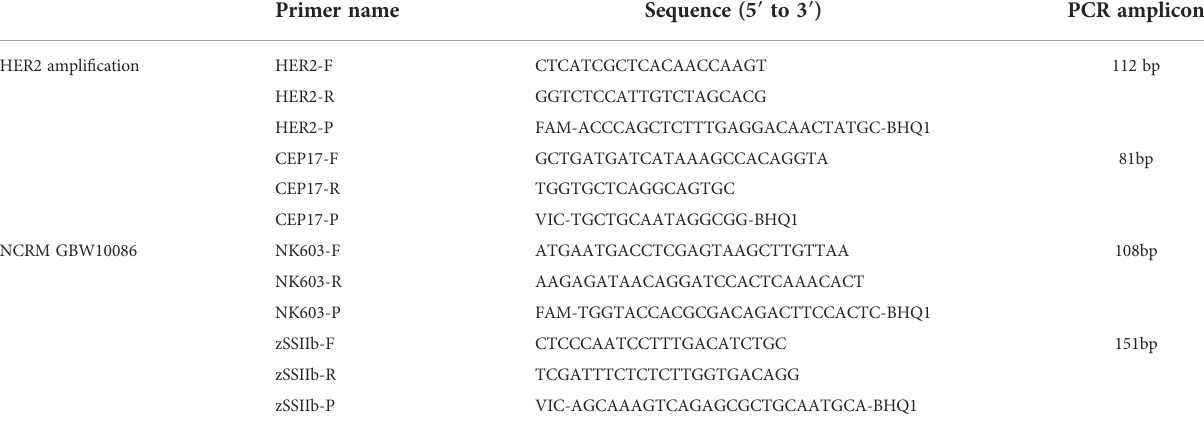
TABLE 1 PCR assays primers used for certi fi cation